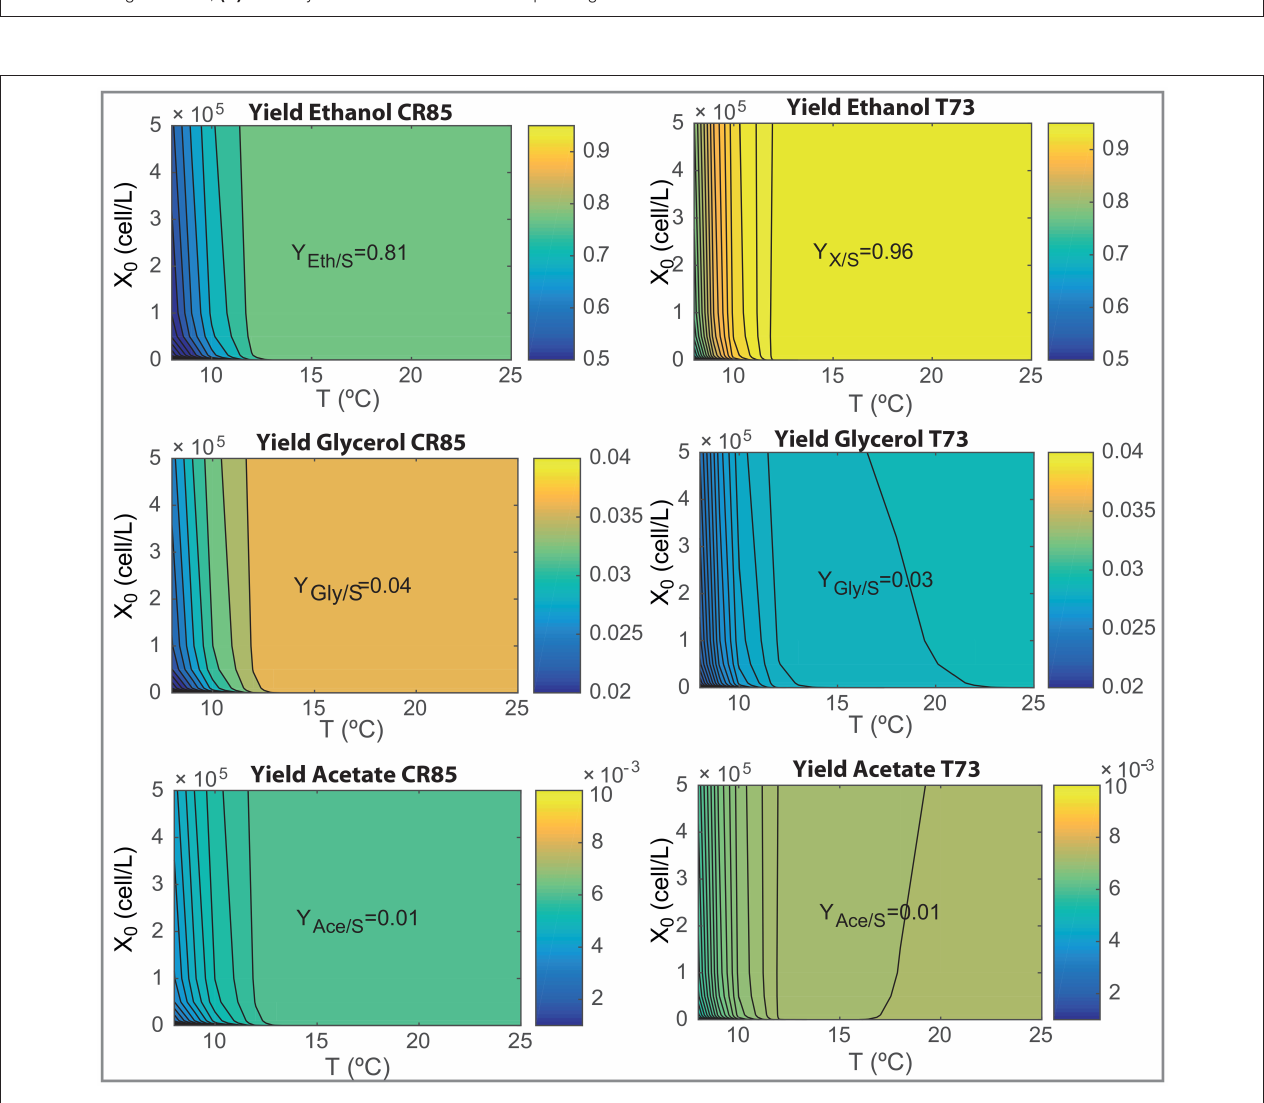
FIGURE 6 | Yields of ethanol, glycerol and acetate as functions of the initial inoculation and the fermentation temperatures for both species as obtained with the ensemble model R3.